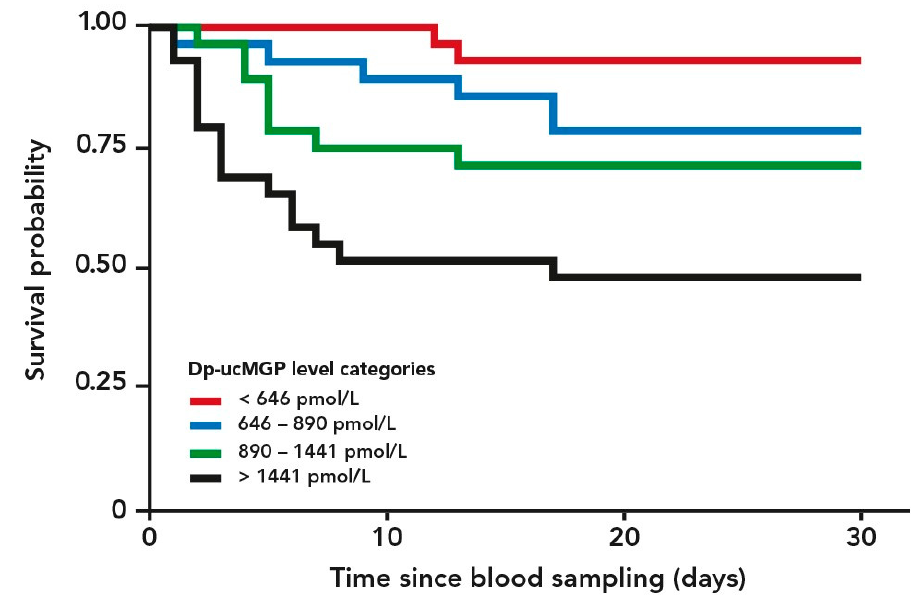
Figure 2. Kaplan–Meier plot of 90-day cumulated risk of dying versus time from blood drawing stratified by levels of dephosphorylated uncarboxylated Matrix Gla Protein (dp-ucMGP) categories (quartiles of dp-ucMGP). High levels of dp-ucMGP reflect low vitamin K status. p -value for log-rank test for comparison of the groups was <0.0001. A correlation matrix of a selection of measured blood biomarkers and clinical param- eters is presented in Figure 3. Dp-ucMGP was positively associated with plasma creati- nine (0.56, p < 0.0001) and urea (0.58, p < 0.0001) and inversely with alanine aminotrans- ferase ( − 0.25, p = 0.01) and lactate dehydrogenase ( − 0.33, p = 0.002). All other correlations were statistically insignificant.